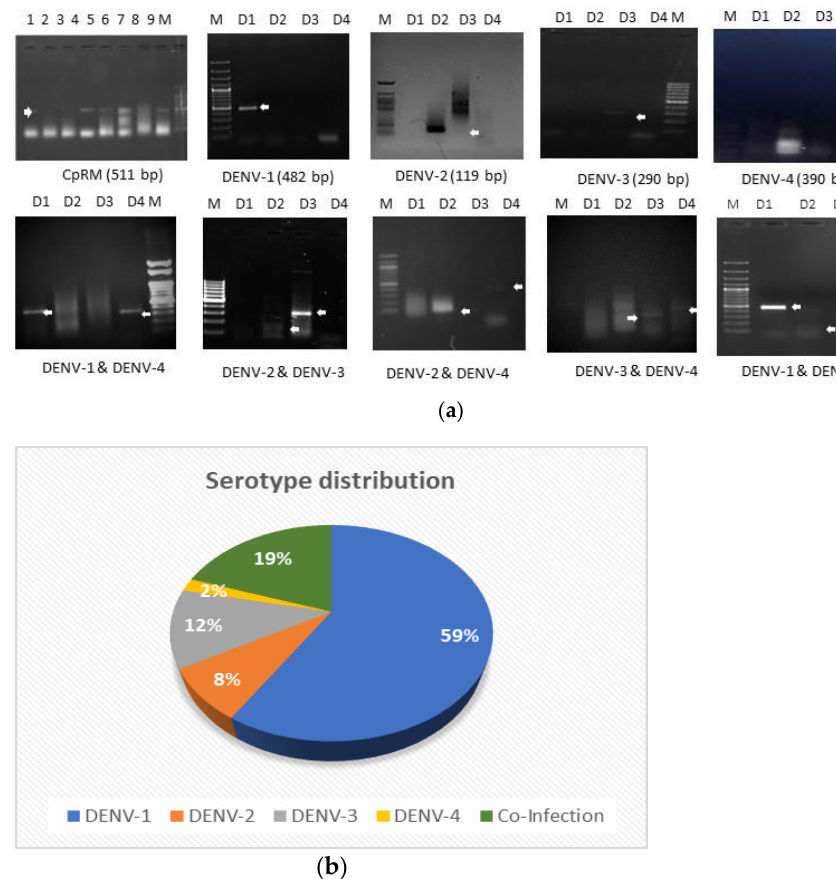
Figure 1. Serotype analysis in the clinical samples collected during the years 2017 – 2020. ( a ) Agarose gel electrophoresis images of the serotypes after RT-PCR and Nested PCR amplification with their specific sizes. ( b ) Pie chart representing the percentage of samples identified for different serotypes and co-infections.